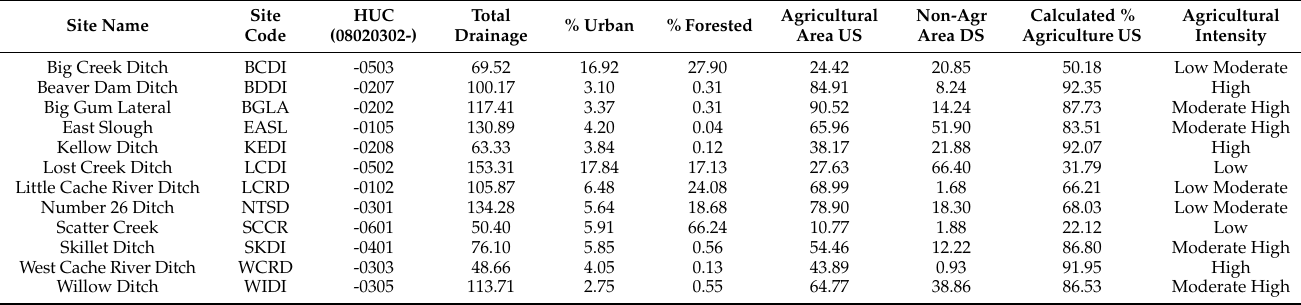
Table 1. Land use of 12 tributaries Upper Cache River Watershed, Arkansas. Site names are listed along with hydrologic unit codes (HUC), total drainage area (km 2 ), the percentage of urban, forested, agricultural drainage area upstream (US; km 2 ), non-agricultural area downstream (DS; km 2 ), calcu- lated % agriculture US of the sampling site, and agricultural intensity classification [31]. Calculated % agriculture US was determined by the following equation: 100 × (Agricultural Land Use Area Upstream/(Total Drainage Area–Non Agricultural Area